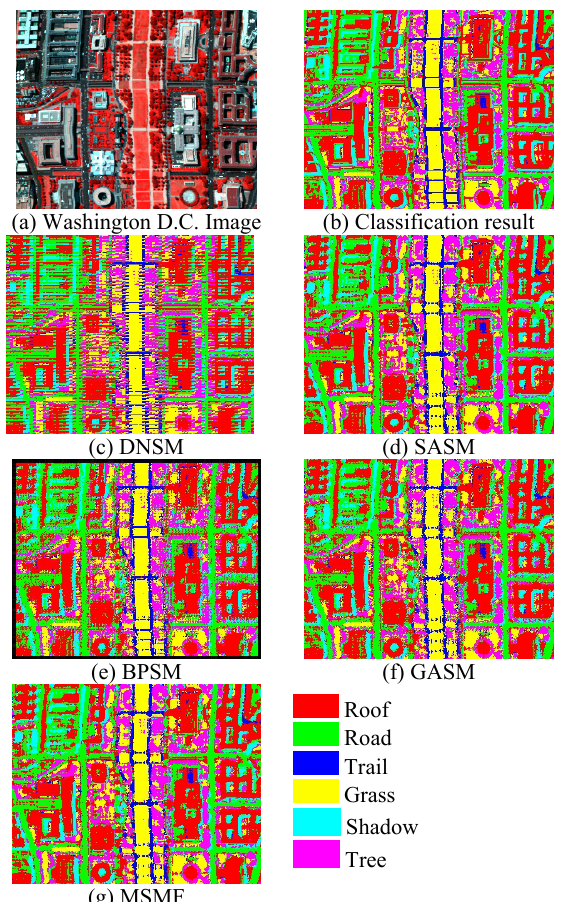
Figure 5. The sub-pixel mapping results in the experiment